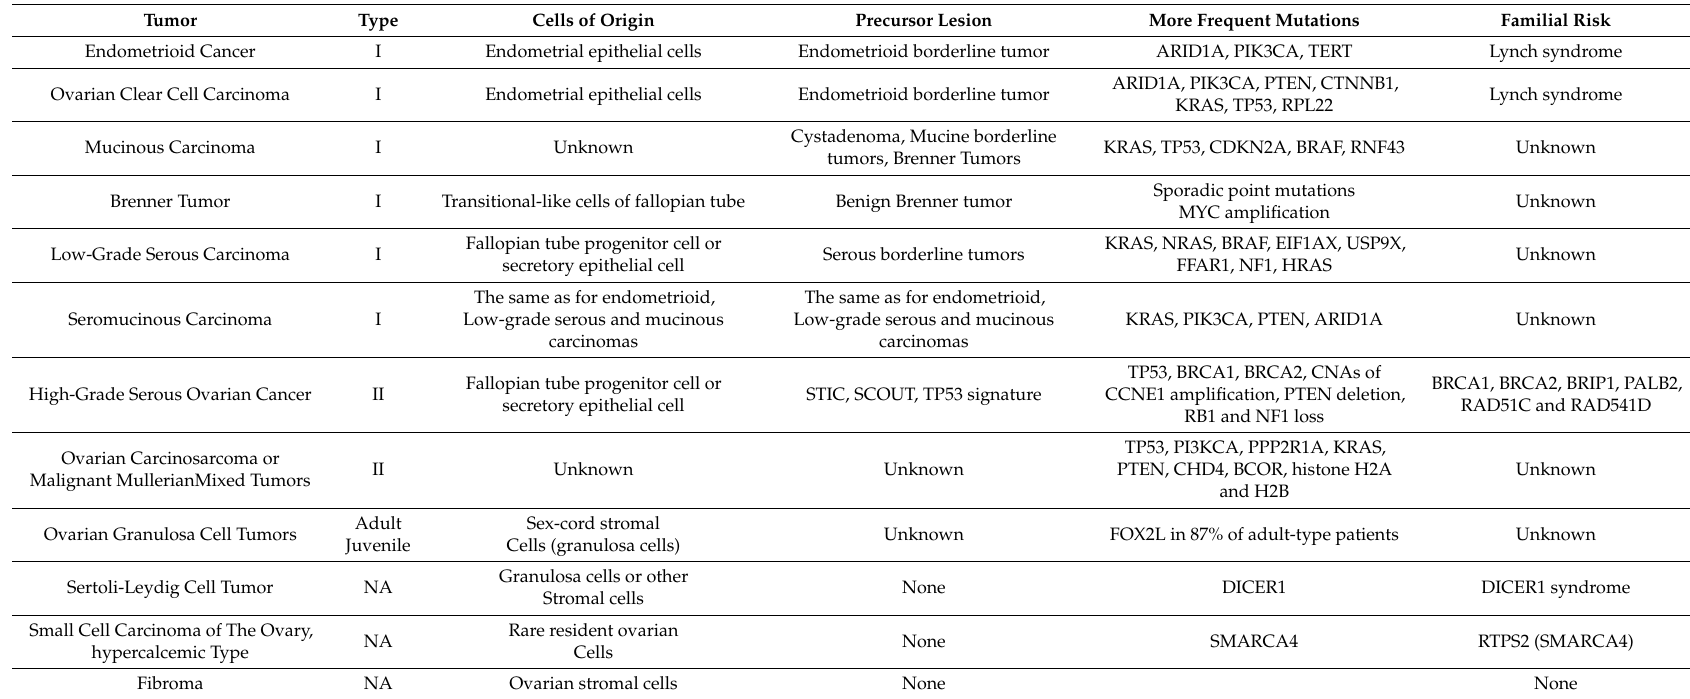
Table 1. Main features of the various types of ovarian